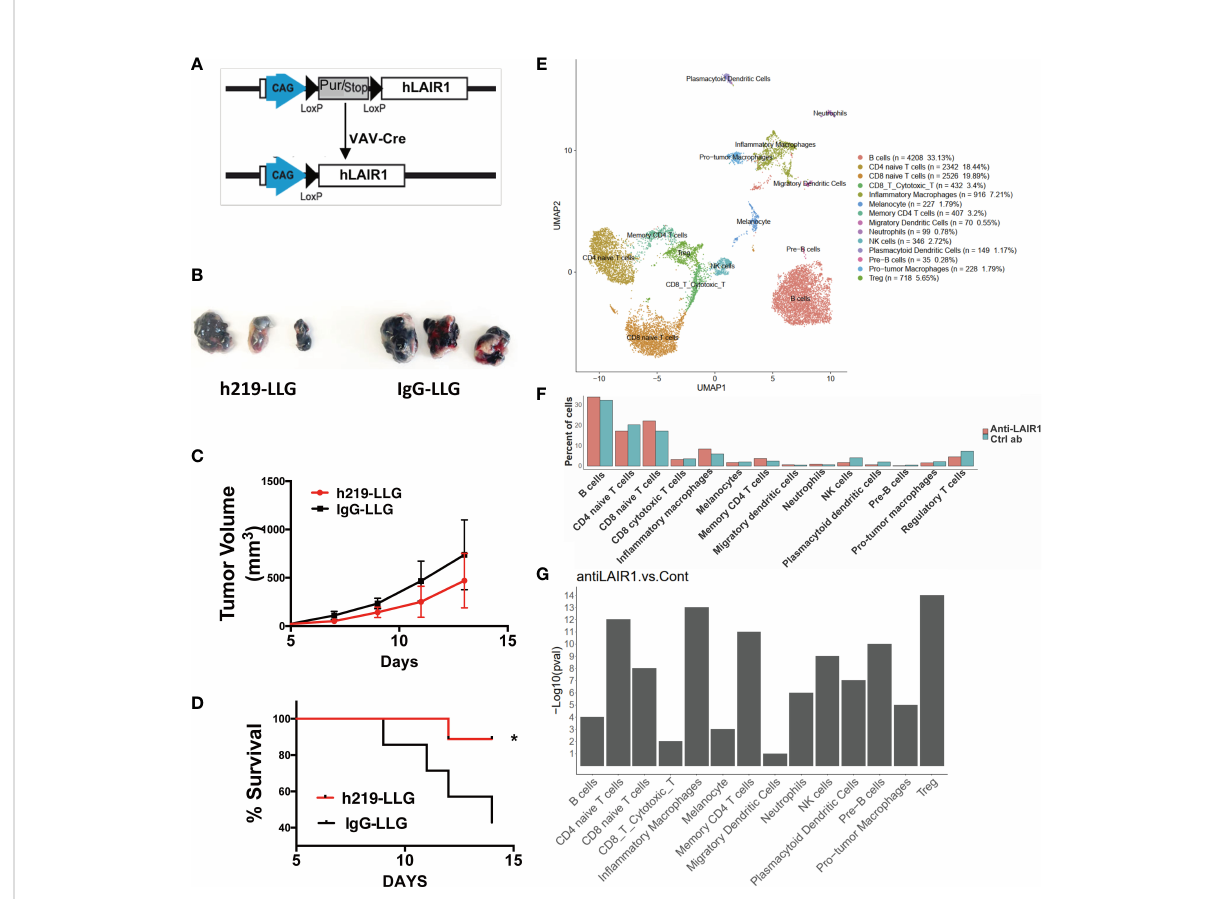
FIGURE 6 LAIR1 blockade alters immune pro fi ling in tumor microenvironment in a syngeneic LAIR1-transgenic mouse tumor model. (A) Schematic of Vav- Cre human LAIR1 transgene in mouse LAIR1 KO background. (B, C) Pictures of tumors and tumor volumes in mice treated by h219-LLG and control in a representative experiment. (D) Survival curve of mice treated by h219 or control antibodies (n=9). (E) Cell type annotation based on unsupervised clustering. (F) Comparison of percentages of immune cell types in TME in mice treated by h219-LLG or control antibodies. (G) Chi-square test P-values of percentage changes of immune cell types treated by h219-LLG or control antibodies. As Statistical Analysis in Methods stated: * indicates p <